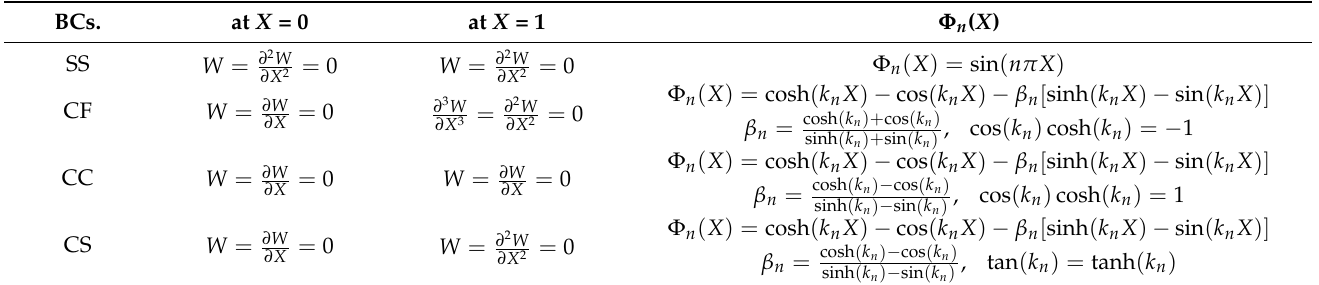
Table 1. Boundary conditions and the associated mode shape